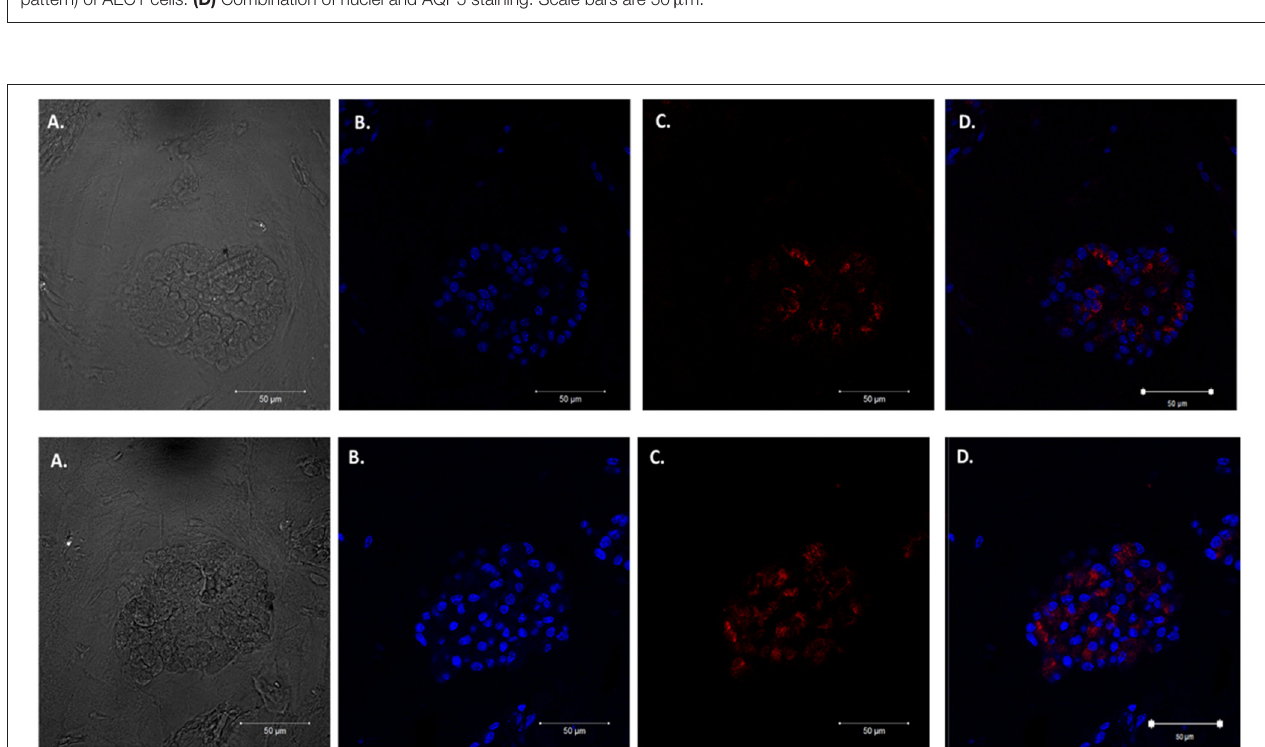
FIGURE 3 | Type 2 alveolar cell marker expression. Two independent organoids labeled with Surfactant C antibodies (SFTPC), cytoplasmic cell marker for type II alveolar epithelial cells pseudo labeled red. Left to right. Two left panels display (A) Bright field images of organoids. (B) Nuclei stained with DAPI. (C) SFTPC (cytoplasmic staining pattern) for AEC2 cells. (D) Combination of DAPI nuclei and SFTPC staining. Scale bars are 50 µ m.